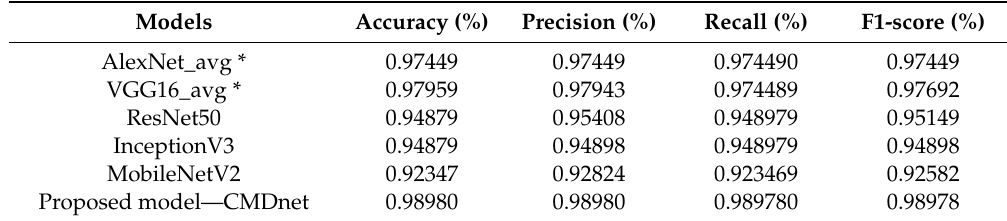
Table 1. Overall accuracies, precisions, recalls, and F1-scores of Convolutional Neural Network(CNN)- based experimental